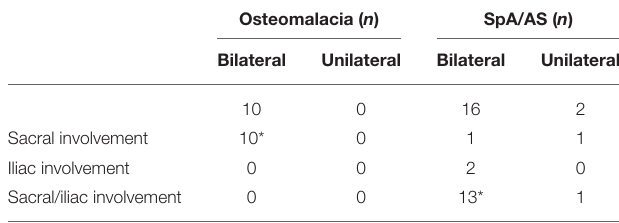
TABLE 5 | Distribution of SIJ involvement in patients in both